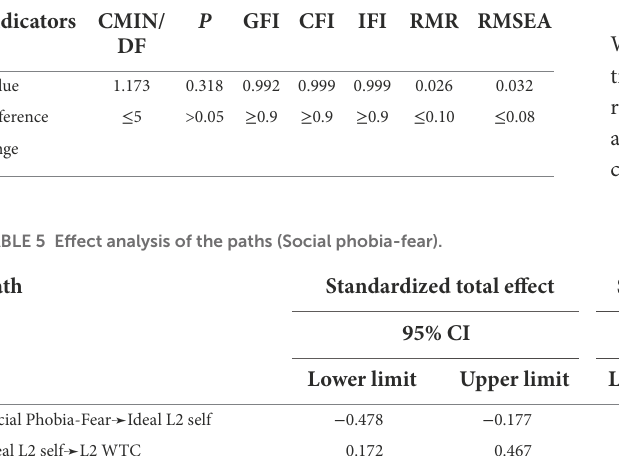
TABLE 4 Data fitting in the structural equation model (social phobia-